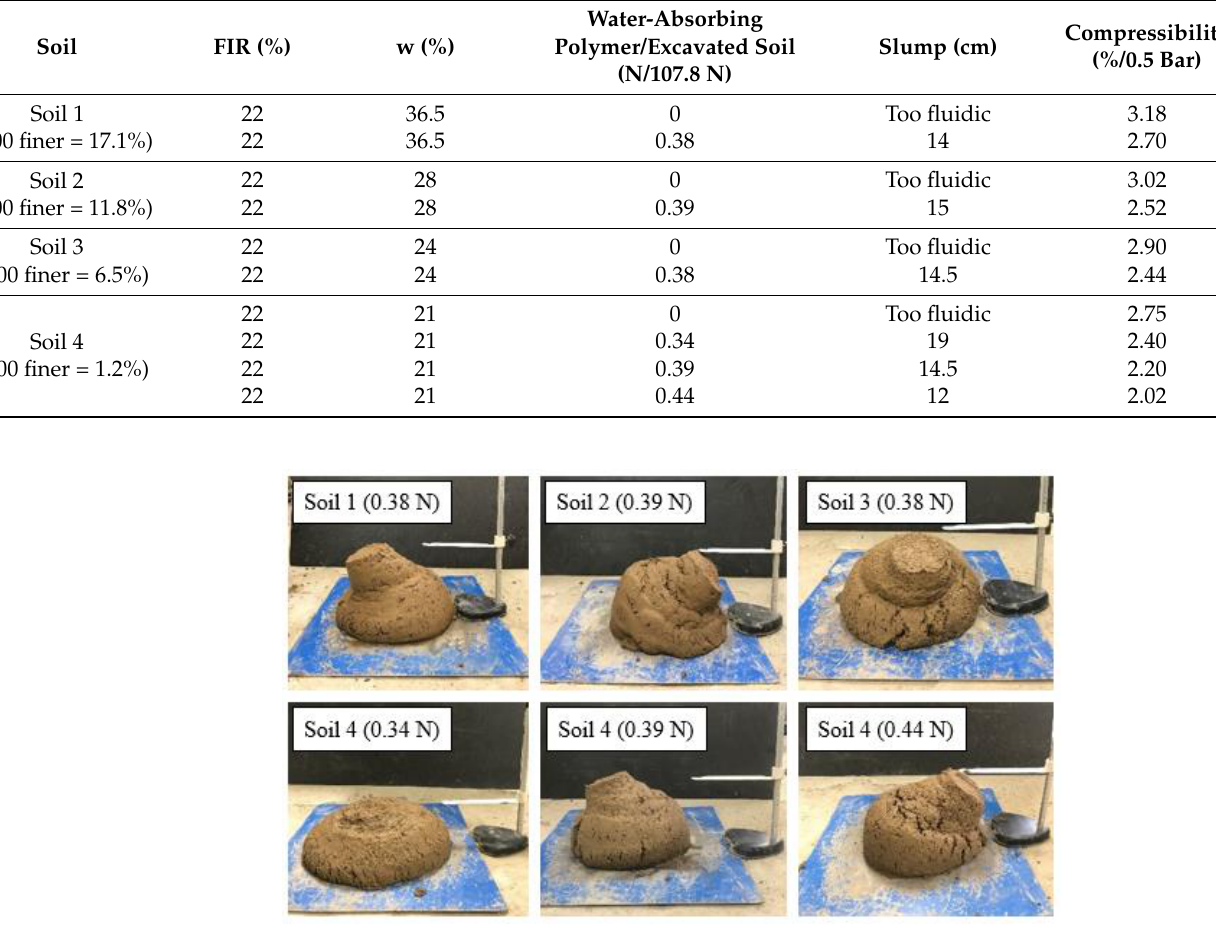
Figure 8. Soil samples after slump tests at varying amounts of added water-absorbing polymers. Even though it was observed that the compressibility decreased (slightly reduced by adding the water-absorbing polymers by up to 26%), these values were still larger than the required 1.9%/0.5 bar. In summary, excavated soils with water contents above the upper bound values proposed in Figure 5 can meet the workability, permeability, and compressibility requirements if they are conditioned with foam added at approximately 22% FIR and around 0.39 N of water-absorbing polymer per 107.8 N of excavated